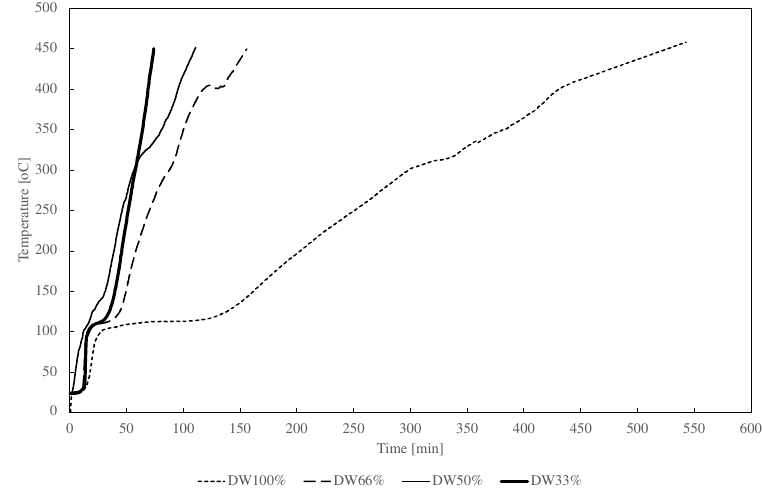
Figure 3. Characteristics of the heating rate of the fixed bed in the reactor for different proportions of distillery waste in the pellets.